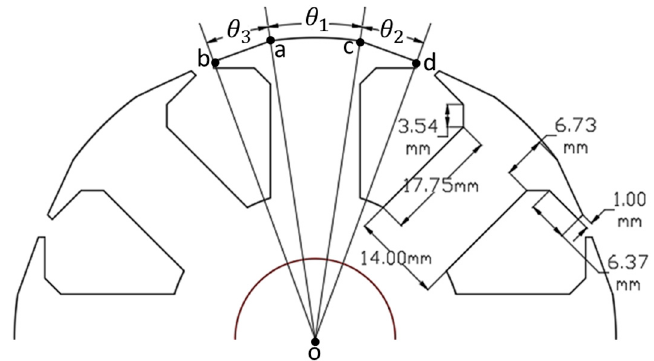
Figure 10. Rotor pole structure (optimal model).